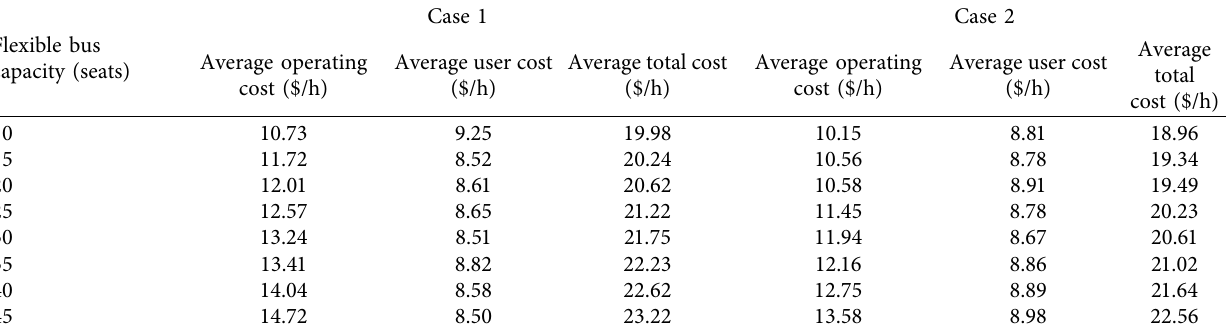
Table 6: Effects of vehicle capacity on costs.